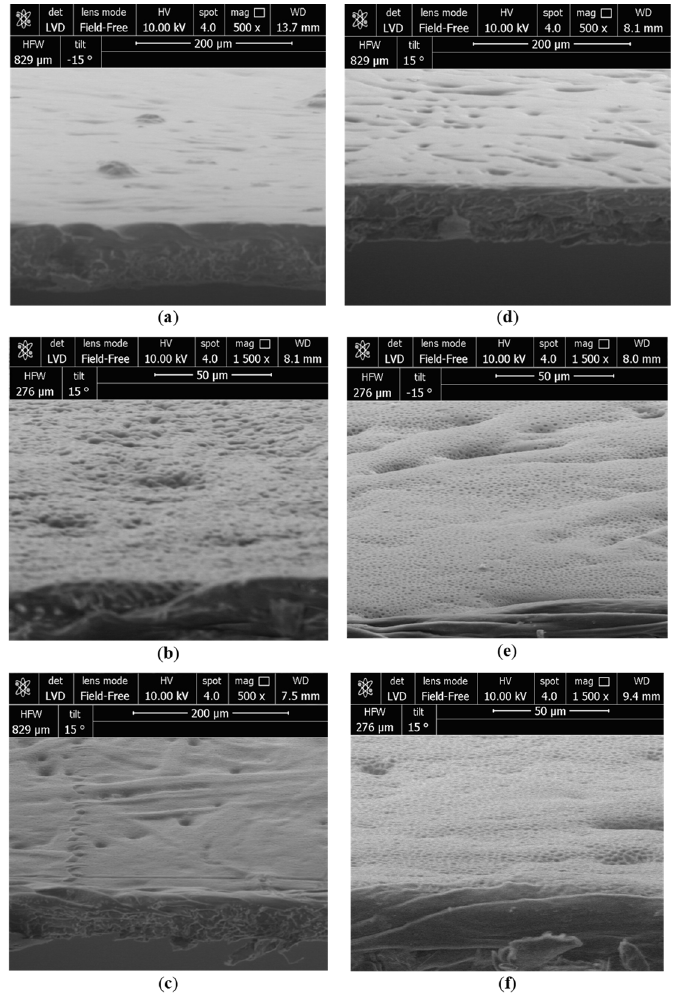
Figure 2. ( a ) PHBV without PEG; ( b ) PHBV with PEG 10%; ( c ) PHBV with PEG 20%; ( d ) PCL without PEG; ( e ) PCL with PEG 10%; and ( f ) PCL with PEG 20%.